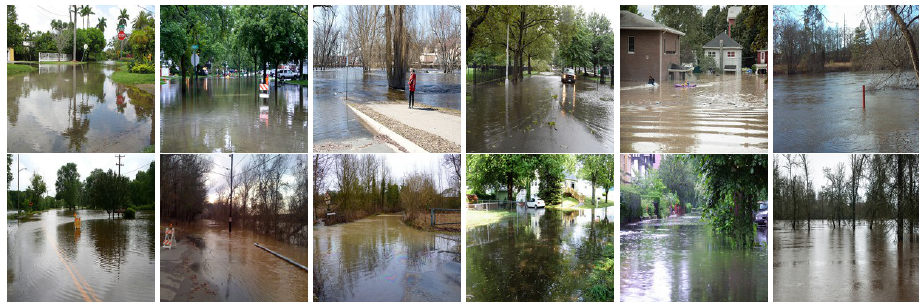
Figure 6. Top 12 images correctly retrieved by VRBagged-Net for the dataset of